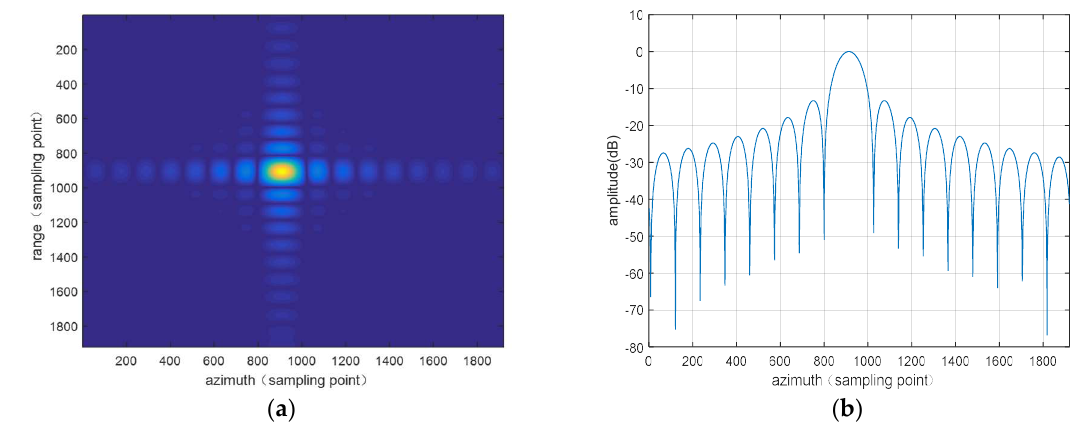
Figure 17. The simulation results for 2° bistatic angle with the consideration of the TCR optimum boresight. ( a ) The point target image after upsampling 48 times; ( b ) the azimuth profile based on the results of the electromagnetic simulation.